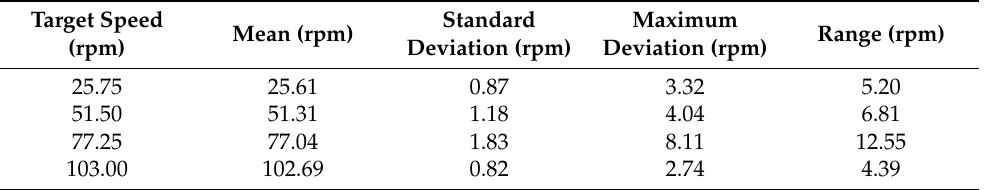
Table 6. Statistical results of the different working